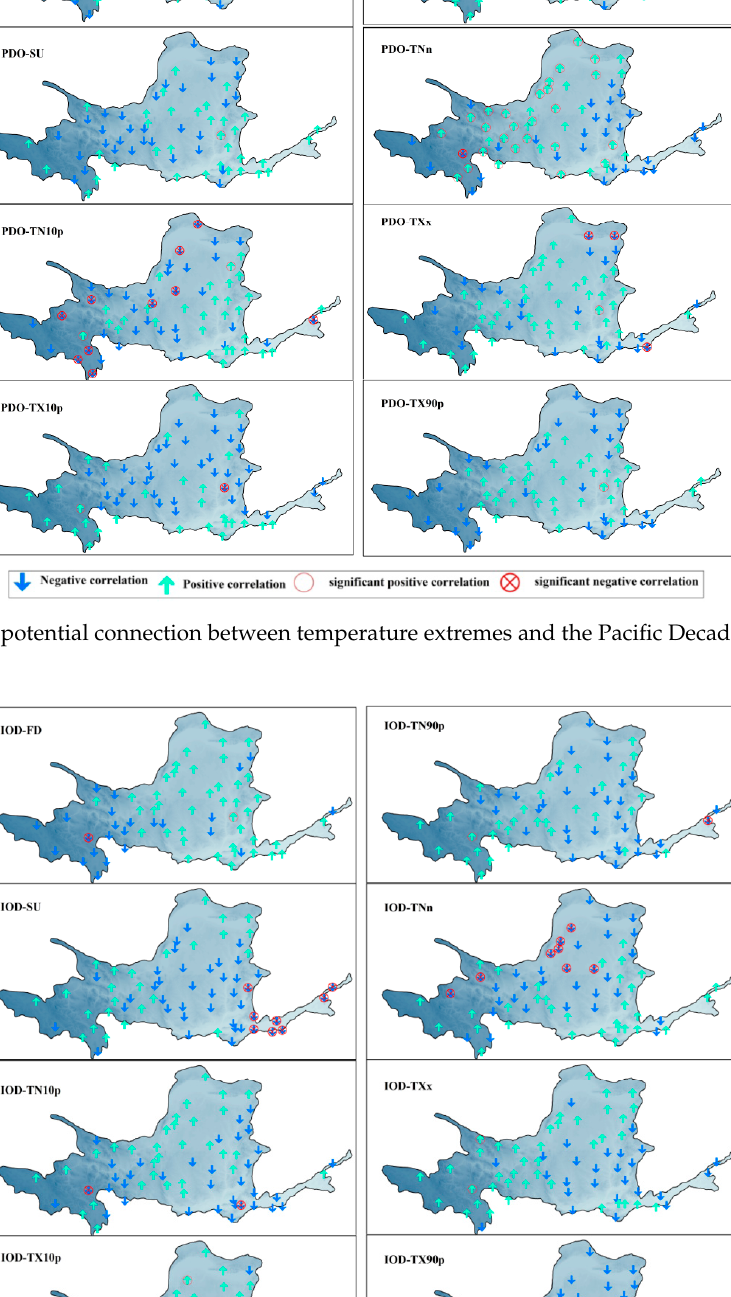
Figure 6. The potential connection between temperature extremes and the North Atlantic Oscillation (NAO).